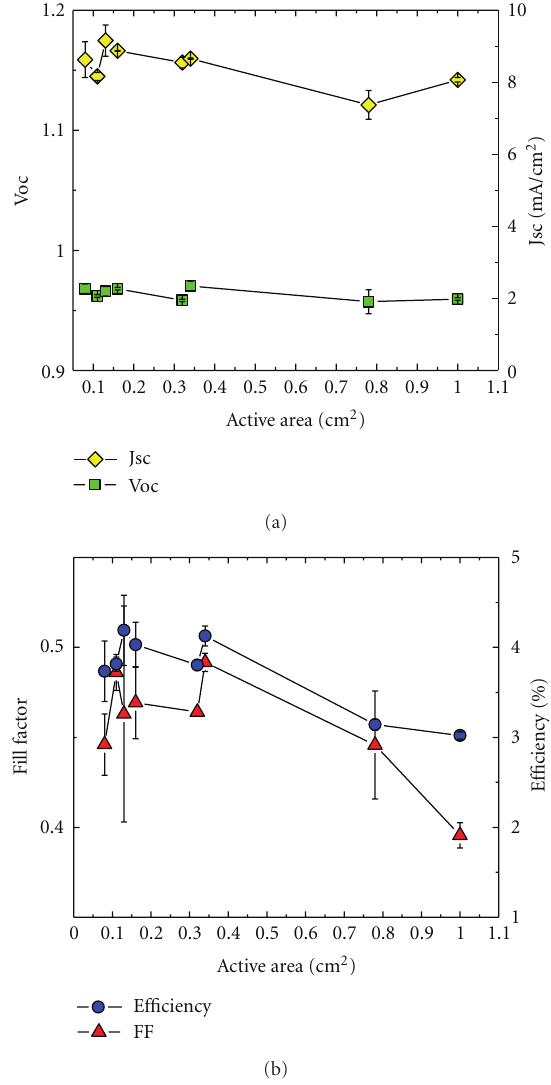
Figure 3: Statistical study with scale bars on (a) open-circuit voltage (Voc square) and short-circuit current (Jsc diamond). (b) Filling factor (triangle) and power conversion e ffi ciency (circle) tested un- der a standard AM 1.5 solar simulator for sprayed devices as a func- tion of active area.